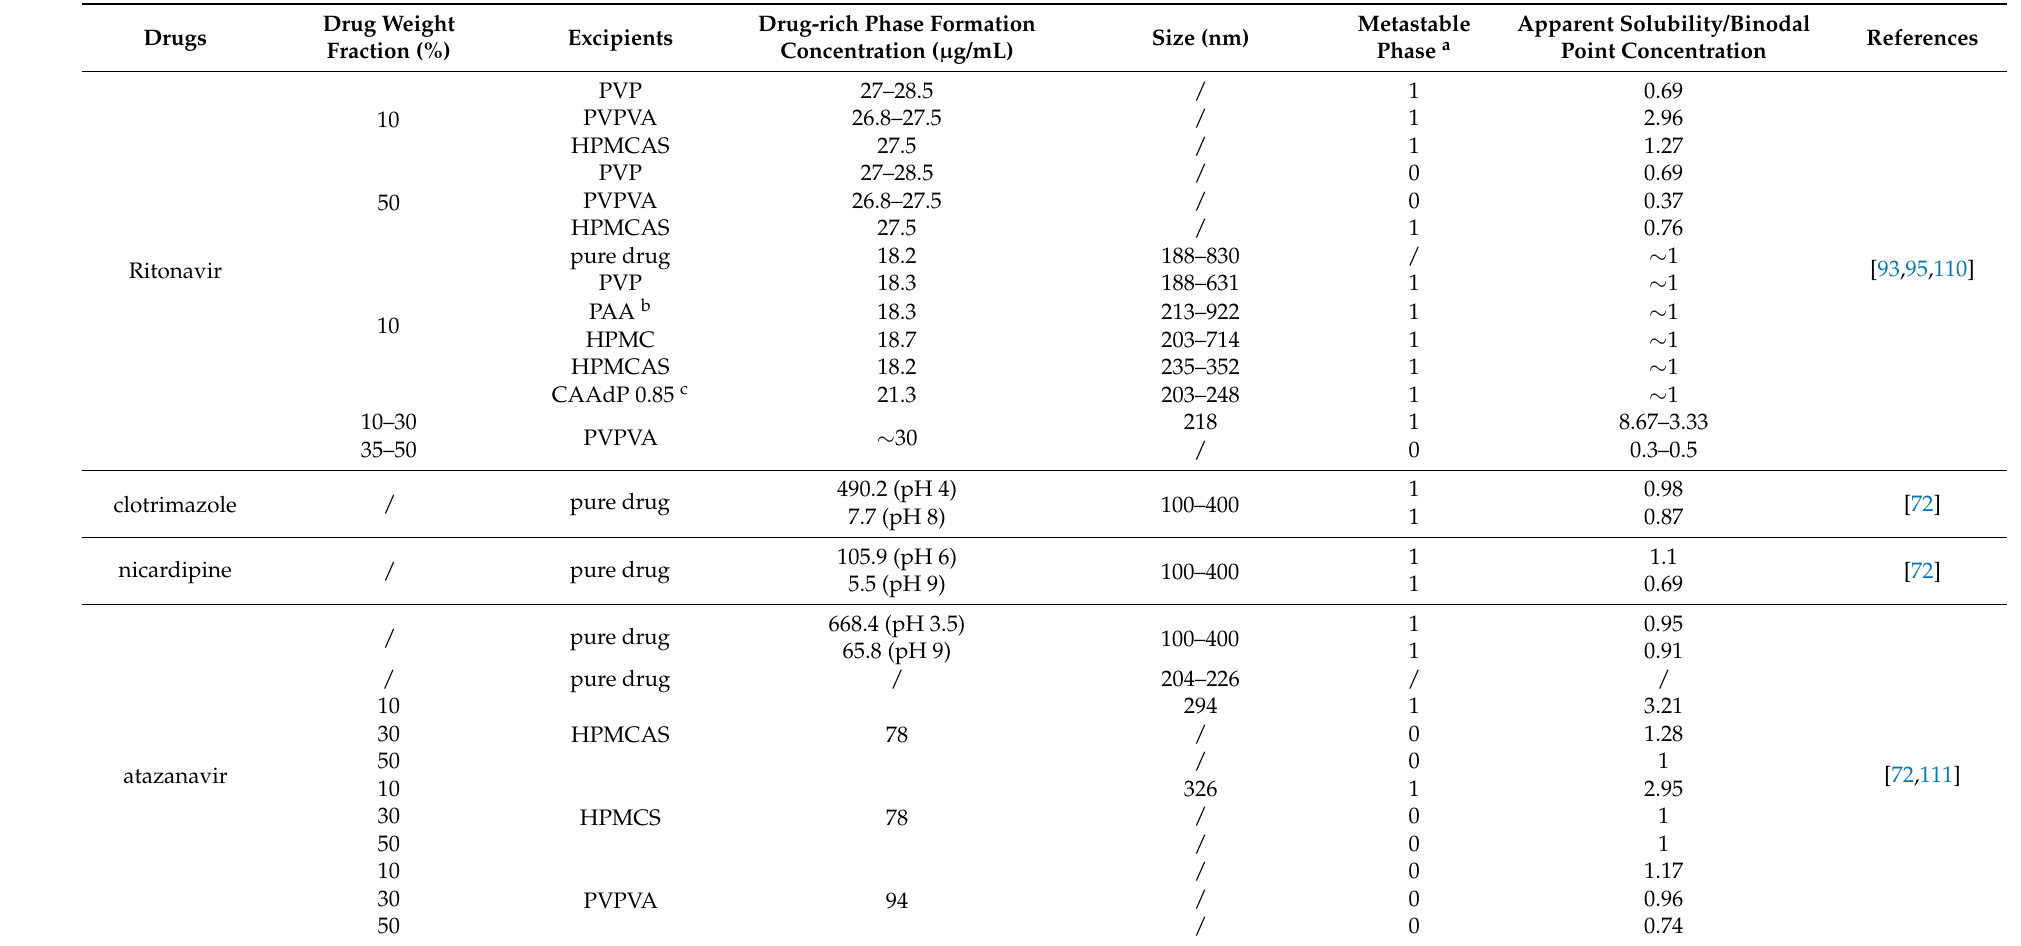
Table 2. Reported drug-rich phases during ASD dissolution over the last